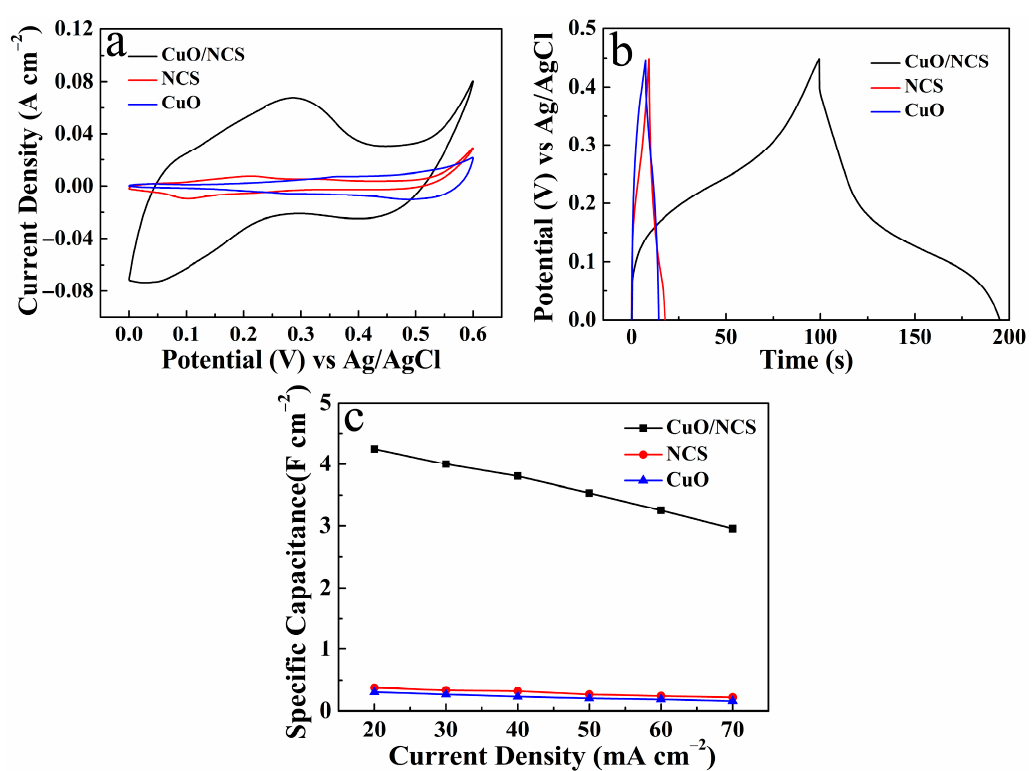
Figure 6. Comparison of energy storage properties of the CuO/NCS, NCS, and CuO electrodes: ( a ) CV curves; ( b ) GCD curves; ( c ) C s at di ff erent current densities.